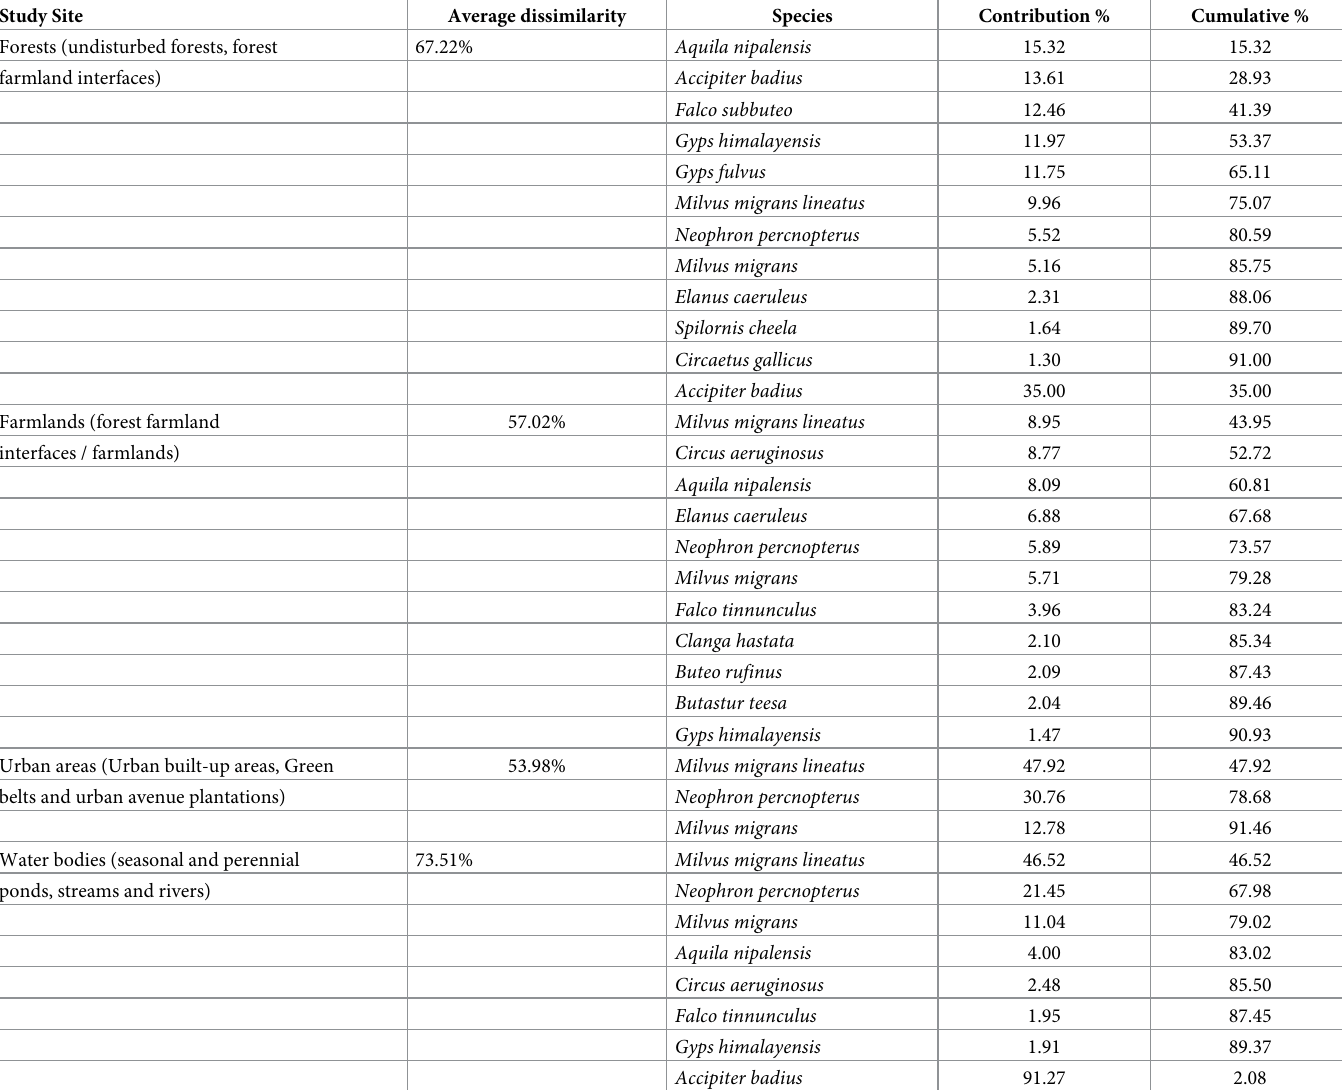
Table 3. SIMPER results explaining contribution percentage (similarity) of representative species / sub-species and average dissimilarity for the habitat